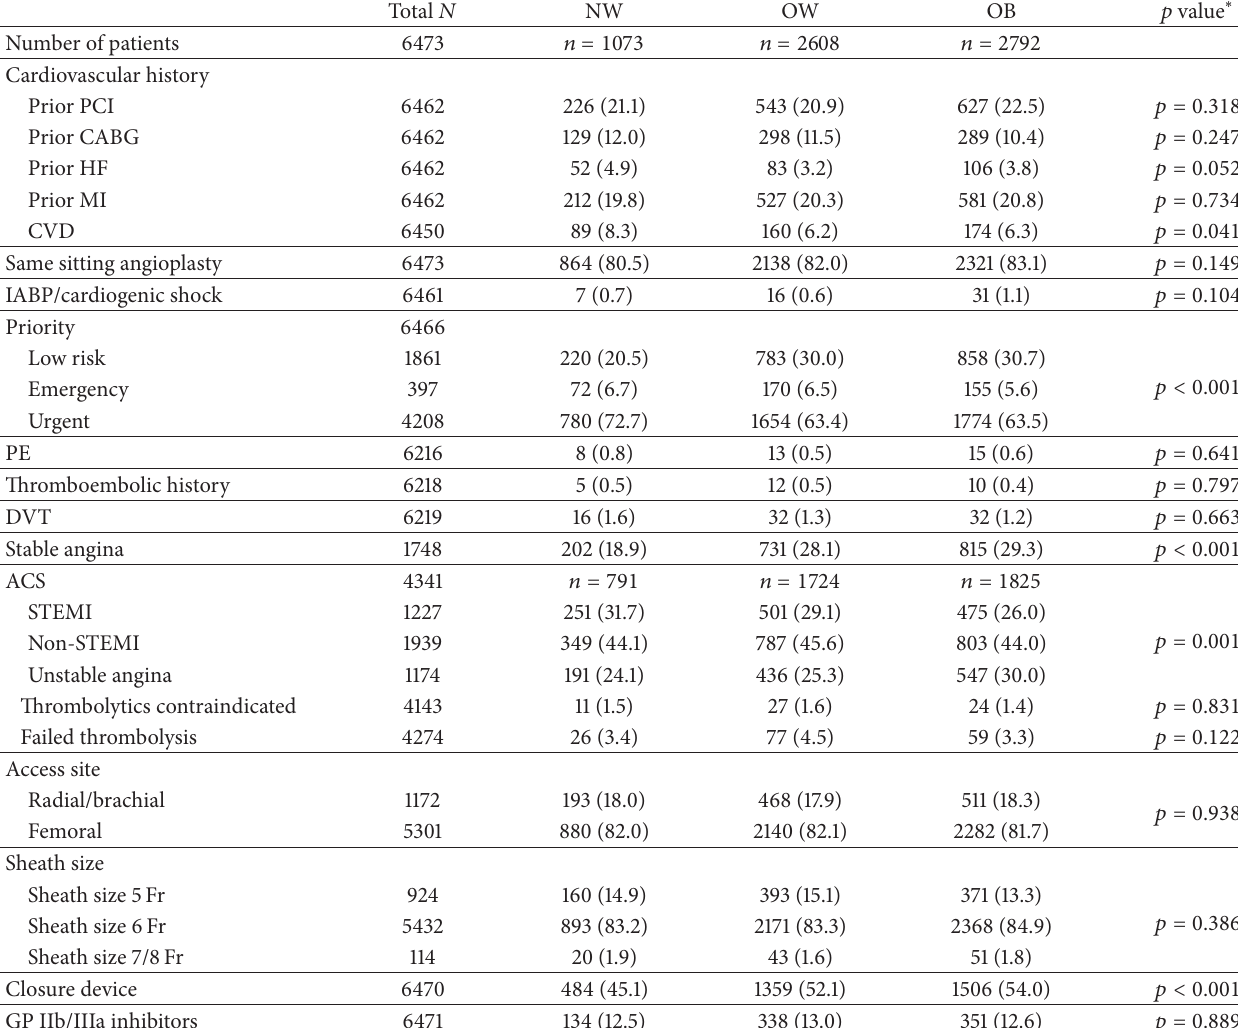
Table 3: Admitting clinical, angiographic, and procedural data for patients undergoing PCI according to BMI category. Total